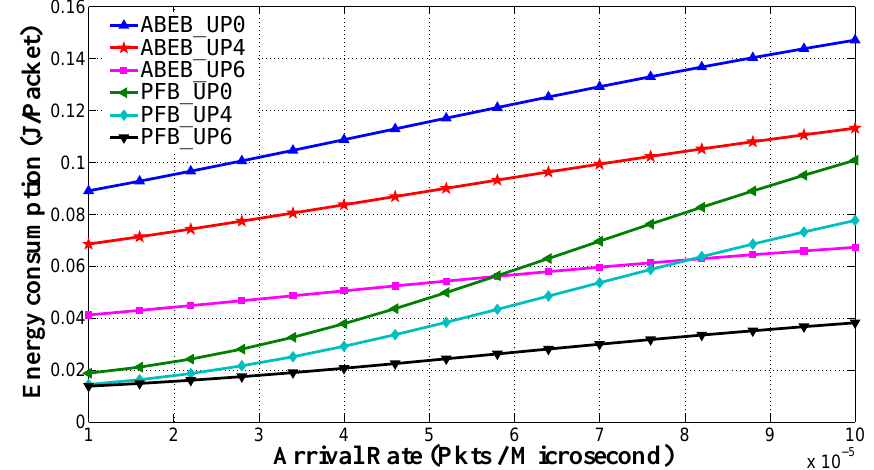
Figure 15. Energy consumption of UP s in the heterogeneous case for for different backoff